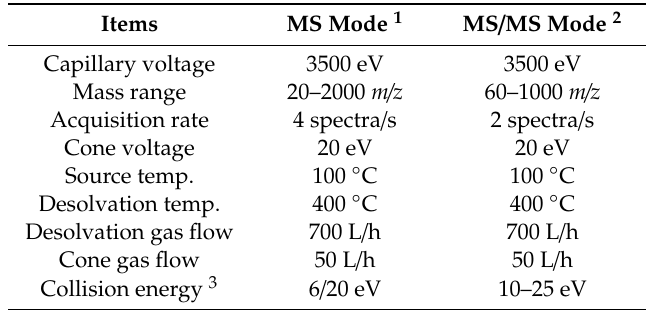
Table 1. Optimized conditions of quadrupole time-of-flight mass spectrometry (Q–TOF–MS). Items MS Mode